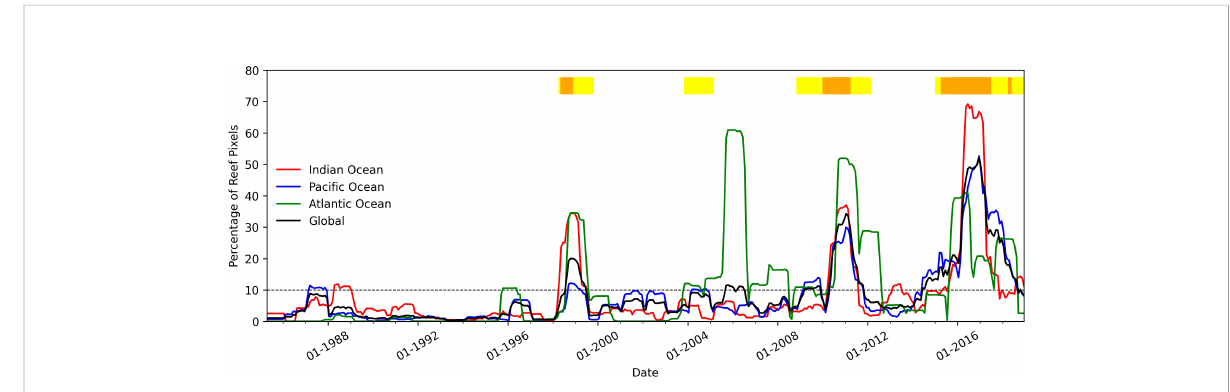
FIGURE 3 Percentage of reef pixels above or equal to the DHW threshold of 4°C-weeks from 1985 to 2018 using an 8-month detection window obtained from the 5-km CoralTemp dataset. The yellow bars at the top of the fi gure indicate that at least 10% of reef pixels in two of the three tropical ocean basins have recently been exposed to heat stress; orange bars indicate that the extent of heat stress is at or above 10% of reef pixels in all three tropical ocean basins, signifying a global coral bleaching